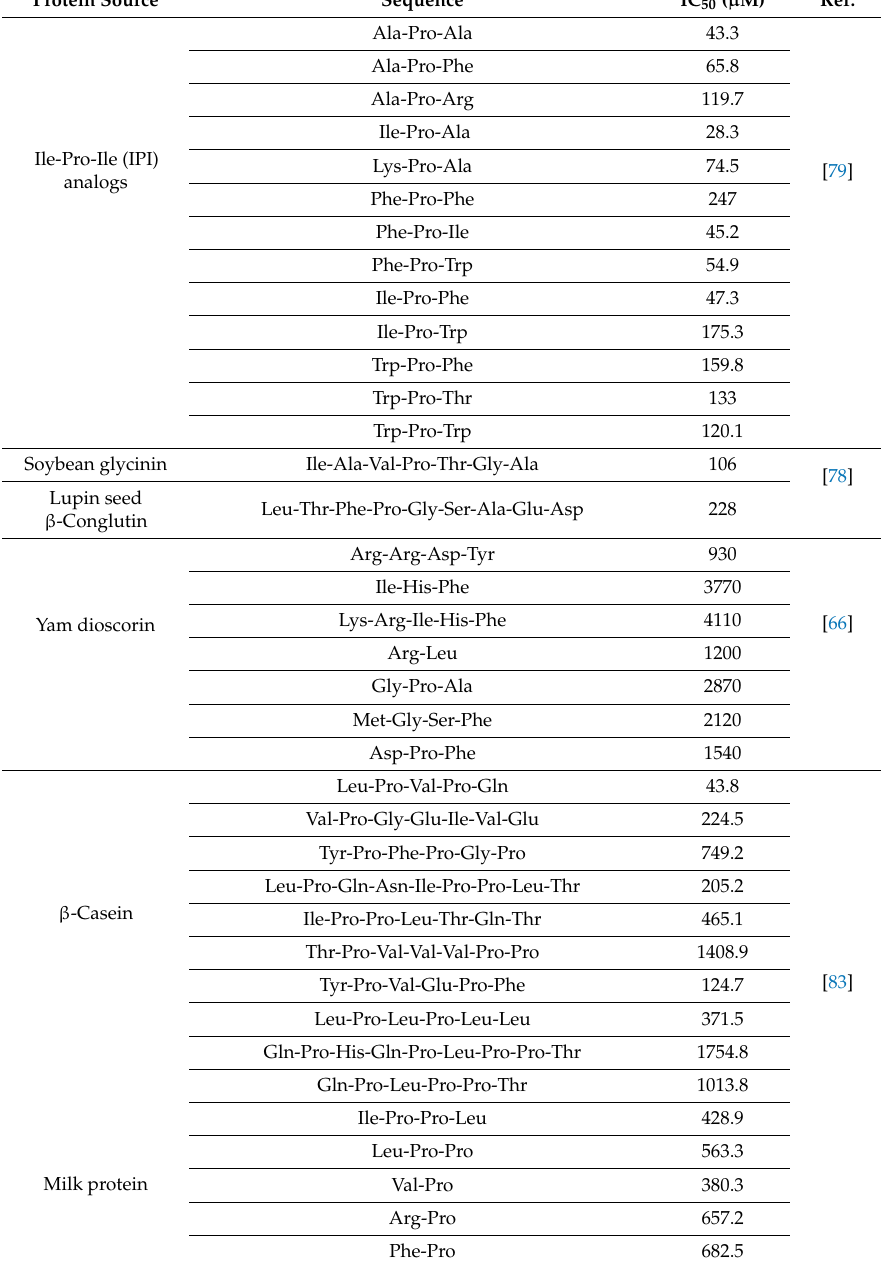
Table 3. DPP-IV inhibitory peptides discovered between 2016 and